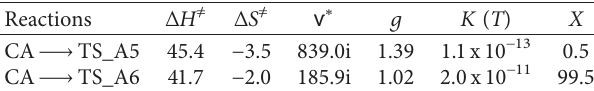
Table 4: Energy barrier of ring opening step when using ONIOM